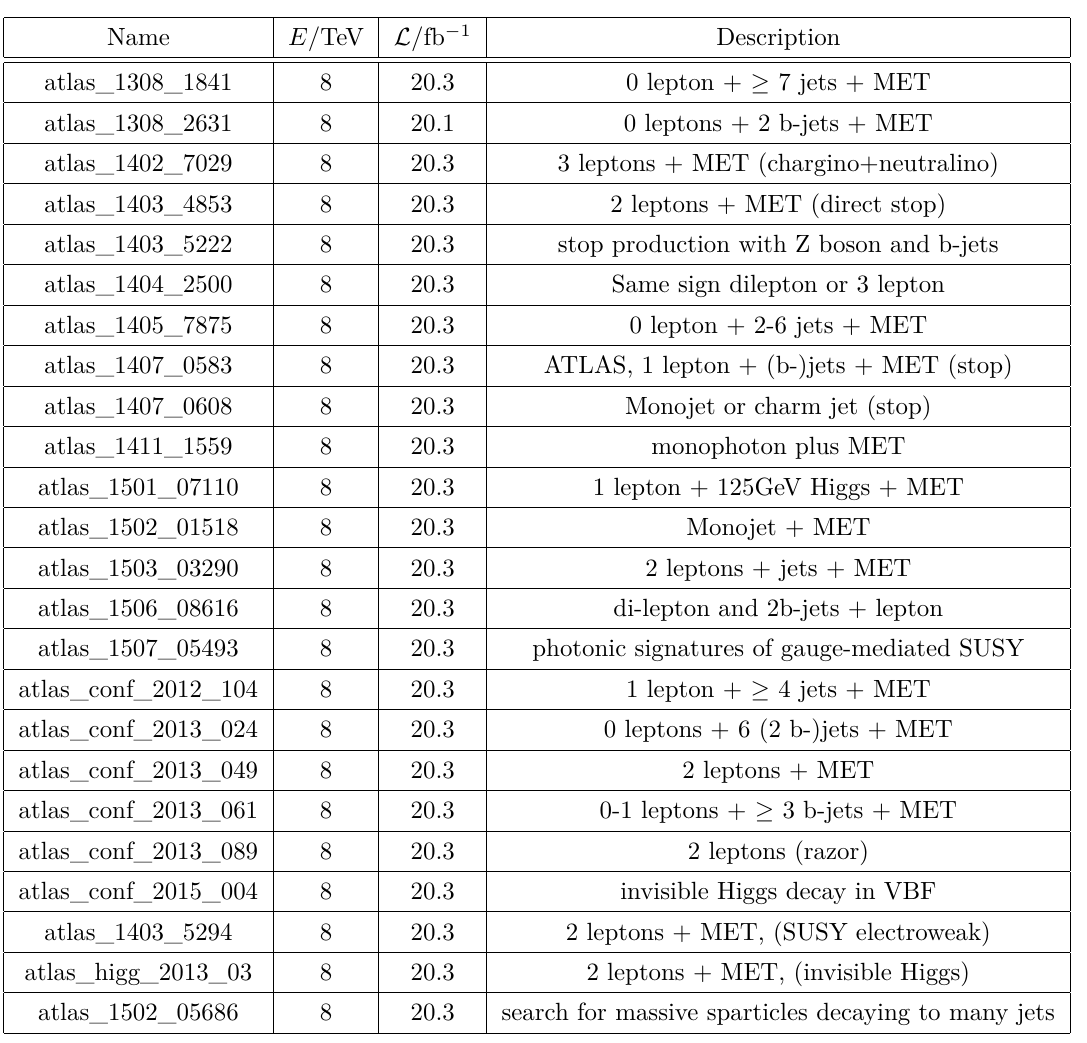
Table 8 . List of 8 TeV ATLAS analyses available in CheckMATE and which have been validated against published experimental